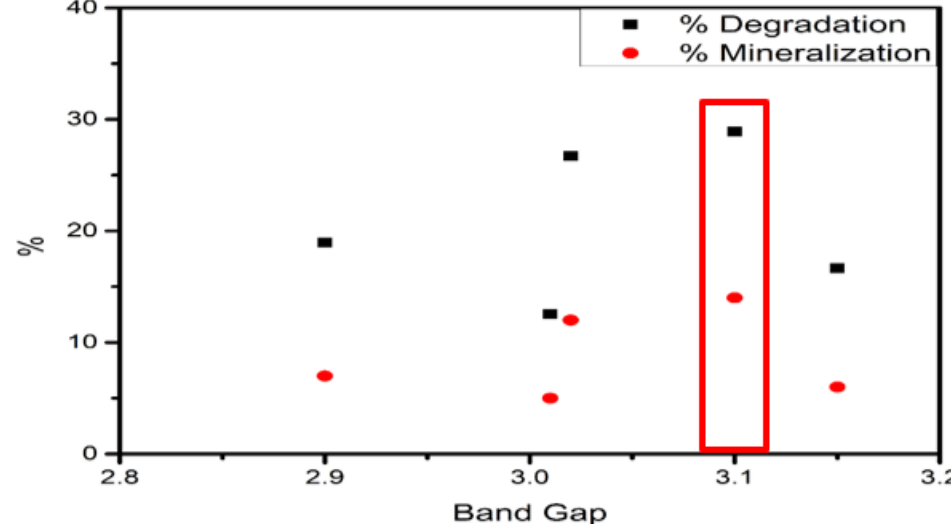
Figure 15. Oxide band gap vs. degradation and mineralization ratio.